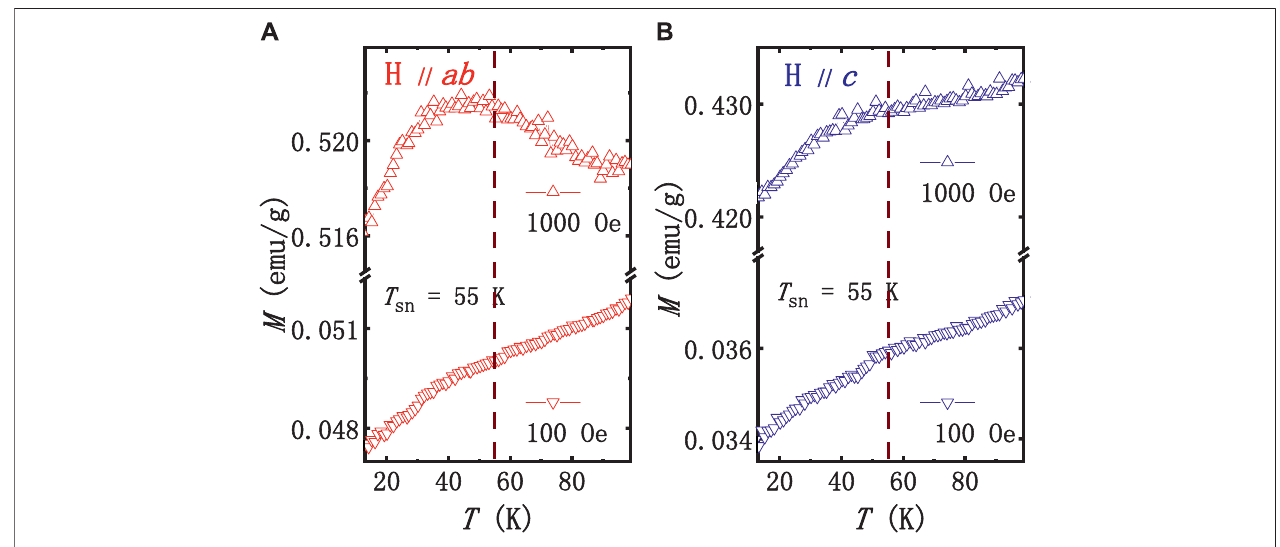
FIGURE7| Temperaturedependence ofthestaticmagnetizationaround T sn underthein-planeandout-of-plane fi eldsfortheFeSecrystalshownin Figure6 [61].